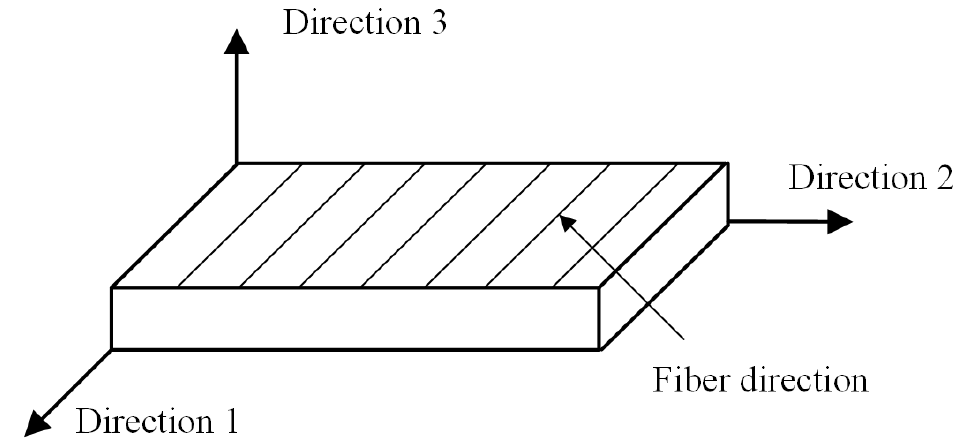
Figure 1. Material direction of composite lamina.